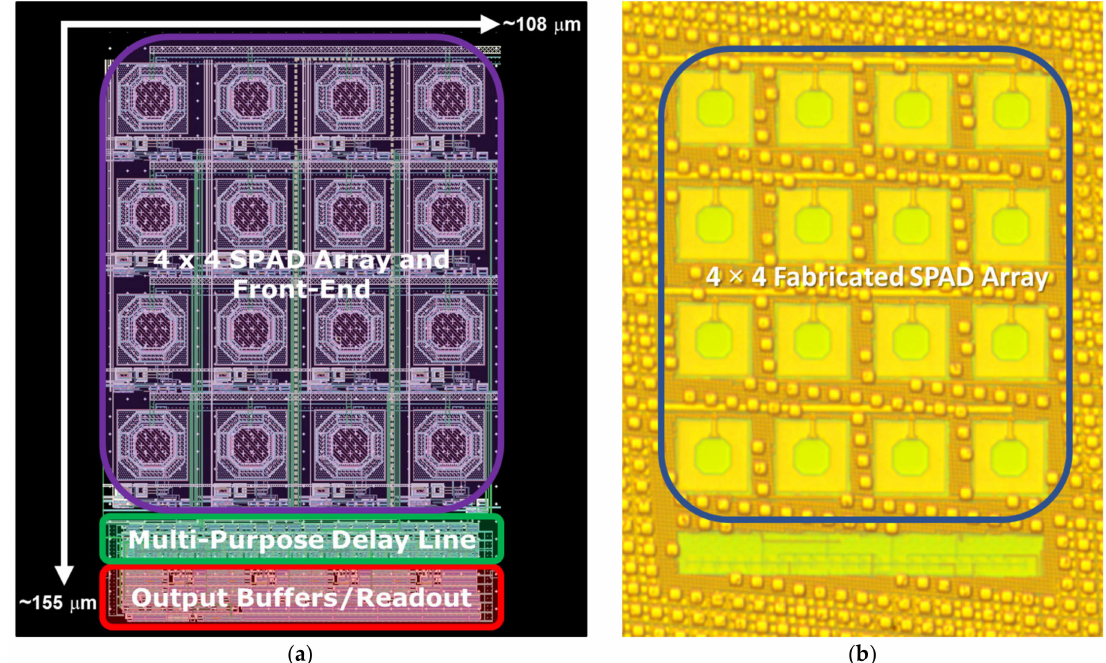
Figure 7. ( a ) Annotated layout and ( b ) micrograph of the fabricated SPAD array.